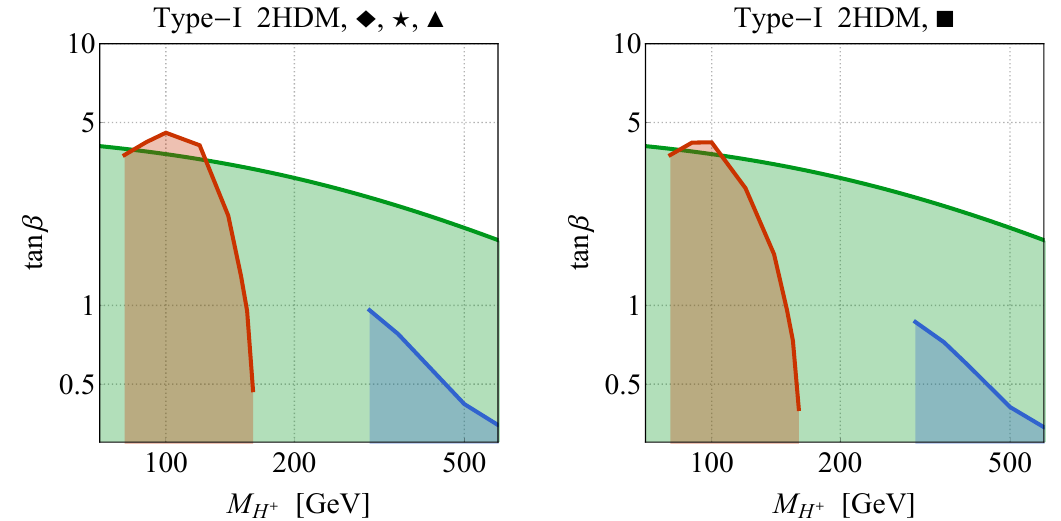
Figure 5 . Constraints on the M H + {tan (cid:12) plane in the type-I 2HDM. The red exclusions are obtained from the CMS H + ! (cid:28) + (cid:23) (cid:28) search [39], while the blue contours indicate the limits set by the ATLAS search for H + ! t (cid:22) b [40]. Overlaid in green is the parameter space disfavoured by the B s ! (cid:22) + (cid:22) (cid:0) measurements of CMS and LHCb [41, 42]. The limits in the benchmark scenarios (3.1), (3.2) and (3.3) are almost identical and shown on the left, whereas the bounds that are relevant in the case of (3.4) are displayed on the right. In both panels the shaded regions are excluded at 95%